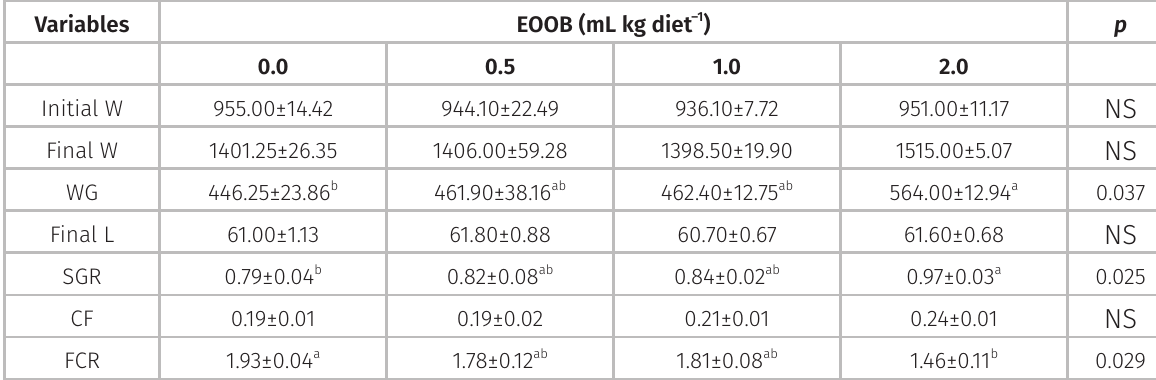
Table II. Growth performance (mean ± SEM) of pirarucu fed with diets containing different concentrations of the essential oil of Ocimum basilicum